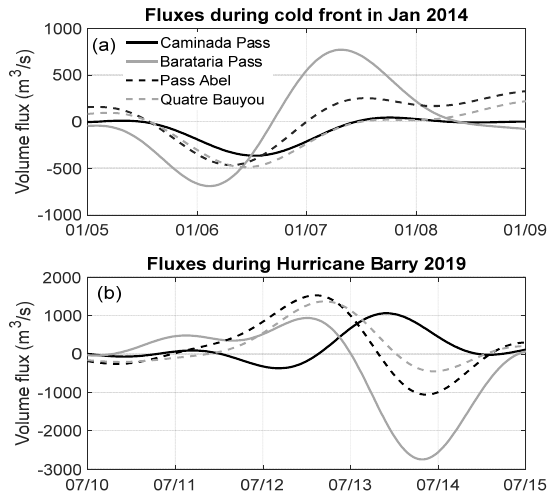
Figure 8. Volume flux through four inlets. ( a ) are fluxes in four passes during cold front, ( b ) are fluxes in four passes during Hurricane Barry.